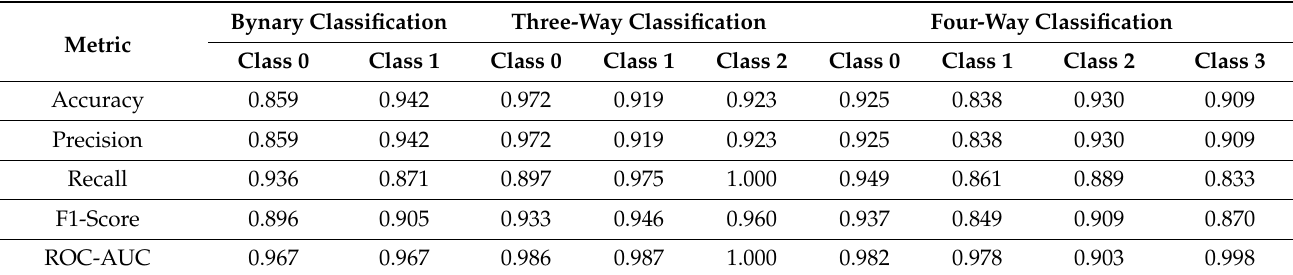
Table 3. Residual architectures performance on the validation set.